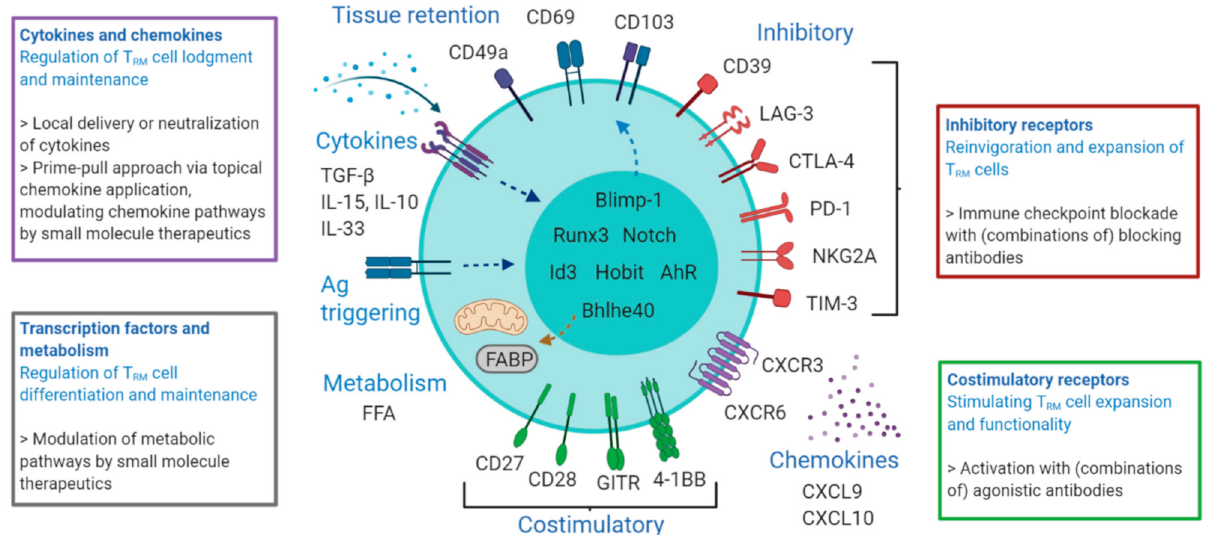
Figure 1. Heterogeneity and therapeutic targeting of CD8 + T RM cells. Integrins, such as CD69, CD49a, and CD103, mediate the tissue retention of CD8 + T cells. Multiple factors, including the cytokine environment, and antigen-triggering and cellular interactions differentially regulate the formation of heterogeneous T RM cell subsets that differ by their costimulatory and inhibitory cell surface molecules, cytokine and chemokine receptors, transcription factors, and intracellular metabolic and signaling pathways. The unique characteristics of the heterogeneous phenotypes and functions of CD8 + T RM cells can be exploited for therapeutic targeting to improve viral immunity and immunotherapies in malignant diseases. Memory CD8 + T cell subsets expressing the inhibitory molecules PD-1, CD39, LAG-3, CTLA-4, NKG2A, and Tim-3 can be successfully targeted by antibodies to unleash effector functions, but specific targeting of CD8 + T RM cells remains challenging. In addition, CD8 + T RM cells can express a variety of costimulatory molecules including CD27, CD28, GITR, and 4-1BB. Agonistic antibodies to these molecules can improve the expansion and cytokine production of CD8 + T RM cells. T RM cell lodgment and maintenance are possible via targeting the cytokine and chemokine receptors on CD8 + T RM cells by (local) delivery of the cytokines and chemokines (e.g., topical application) or by modulating chemokine pathways using small molecule therapeutics. Additionally, tissue residency could be promoted by targeting transcription factors such as Runx3 in adoptive cell therapy treatments that target cancer. Moreover, CD8 + T RM cells have specific metabolic requirements and targeting these might constitute a potential therapeutic approach. Figure created with